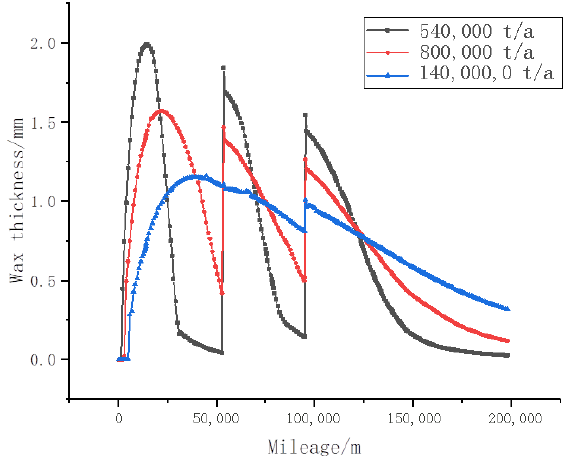
Figure 6. Wax deposition thickness under different